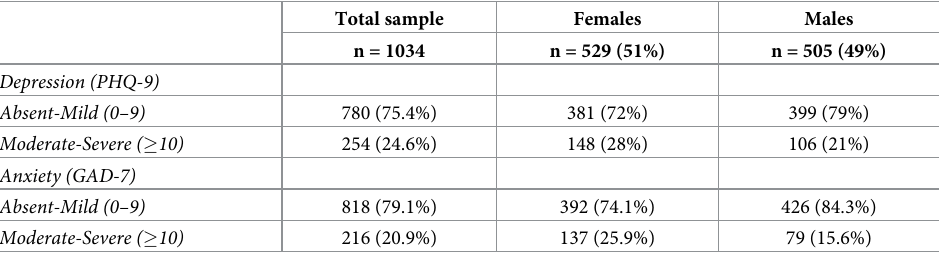
Table 2. Anxiety and depression clinical